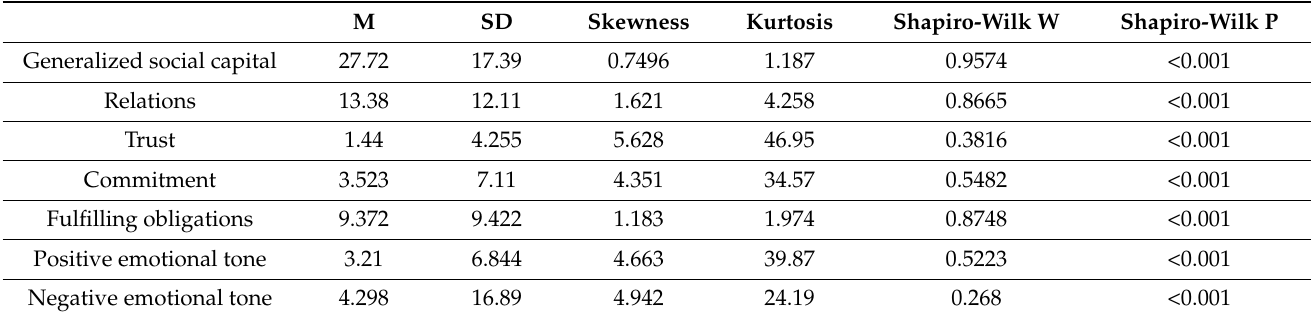
Table 2. Descriptive statistics ( n =